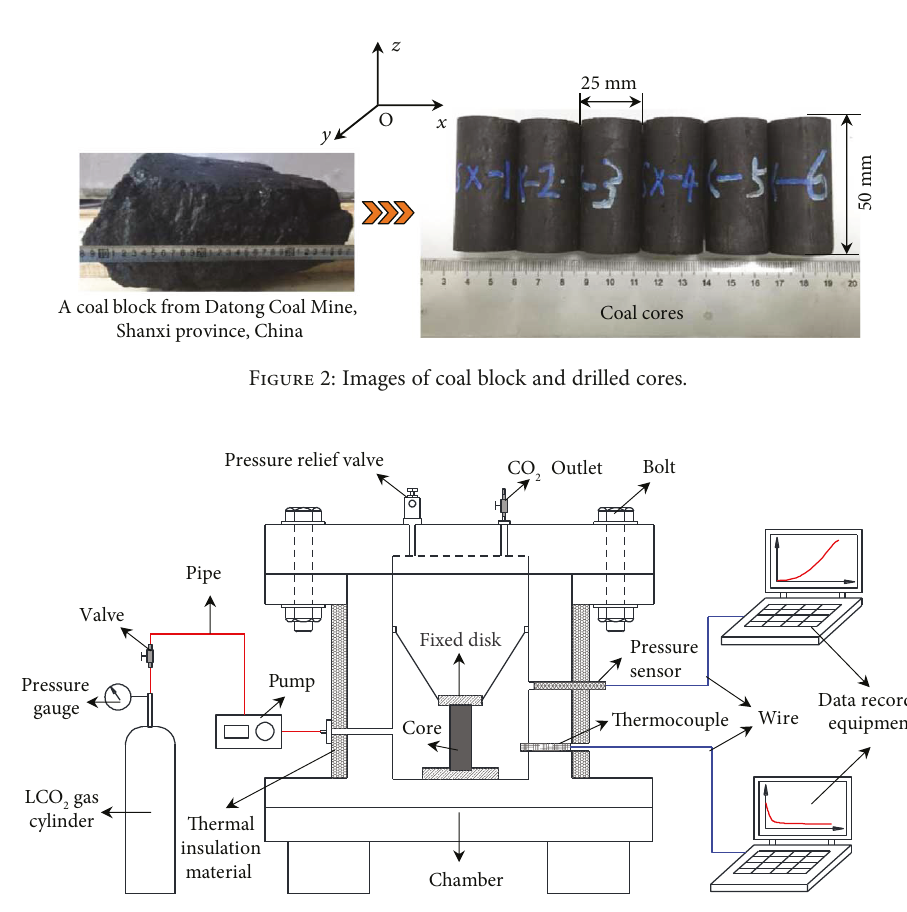
Figure 3: Sketch image of the experimental system. Table 1: Experimental design of six